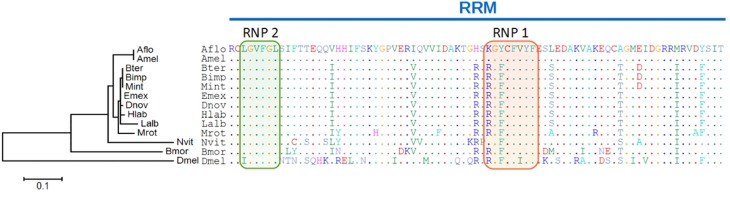
Amino acid alignment of the tra2 RNA recognition motif and phylogenetic tree. The RNA recognition motif (RRM) with two elements (RNP1: red, RNP2: green) known to be directly involved in RNA recognition are highlighted. The maximum likelihood tree branch length represents amino acid changes per site for tra2. Abbreviations are the same as for Figure 2 adding Bmor, Bombyx mori (Lepidoptera); Dmel, Drosophila melanogaster (Diptera); Mint, Melipona interupta.